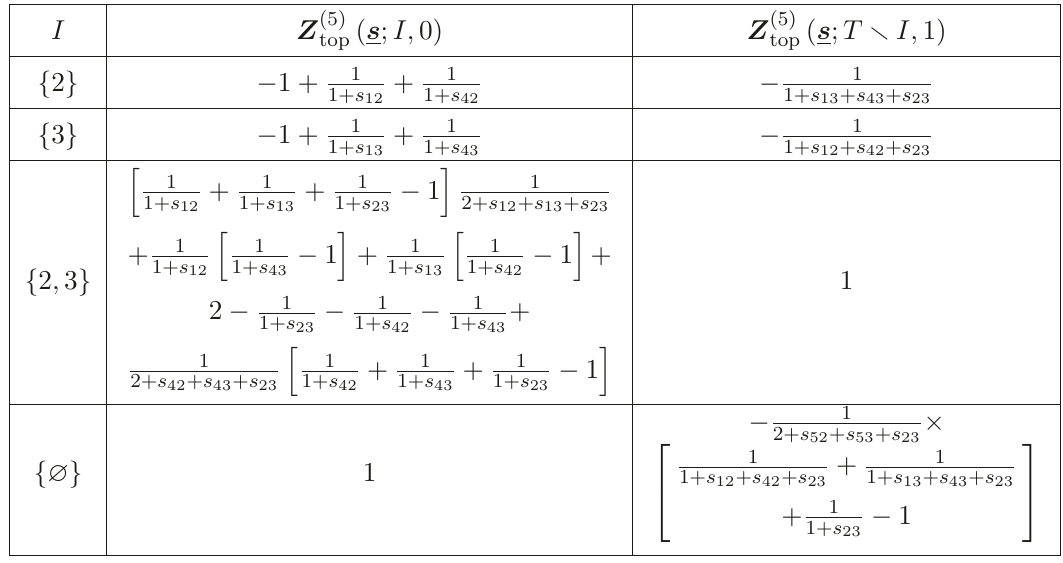
Table 2 . The topological zeta functions Z (5) subset I and its complement T r I